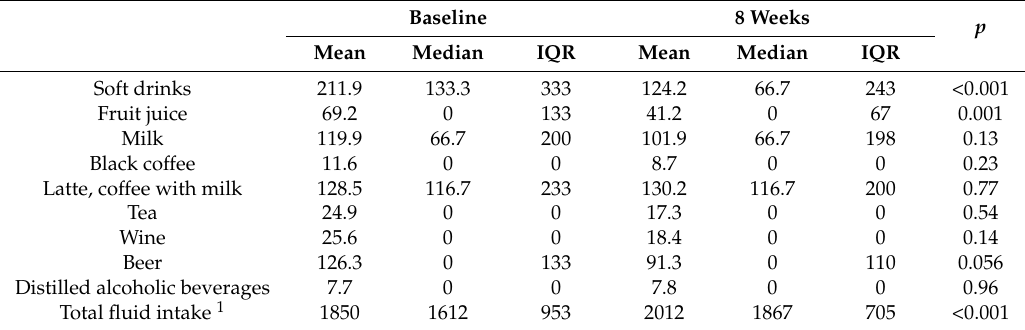
Table 4. Changes in volunteers’ beverages consumption (mL/day) during the